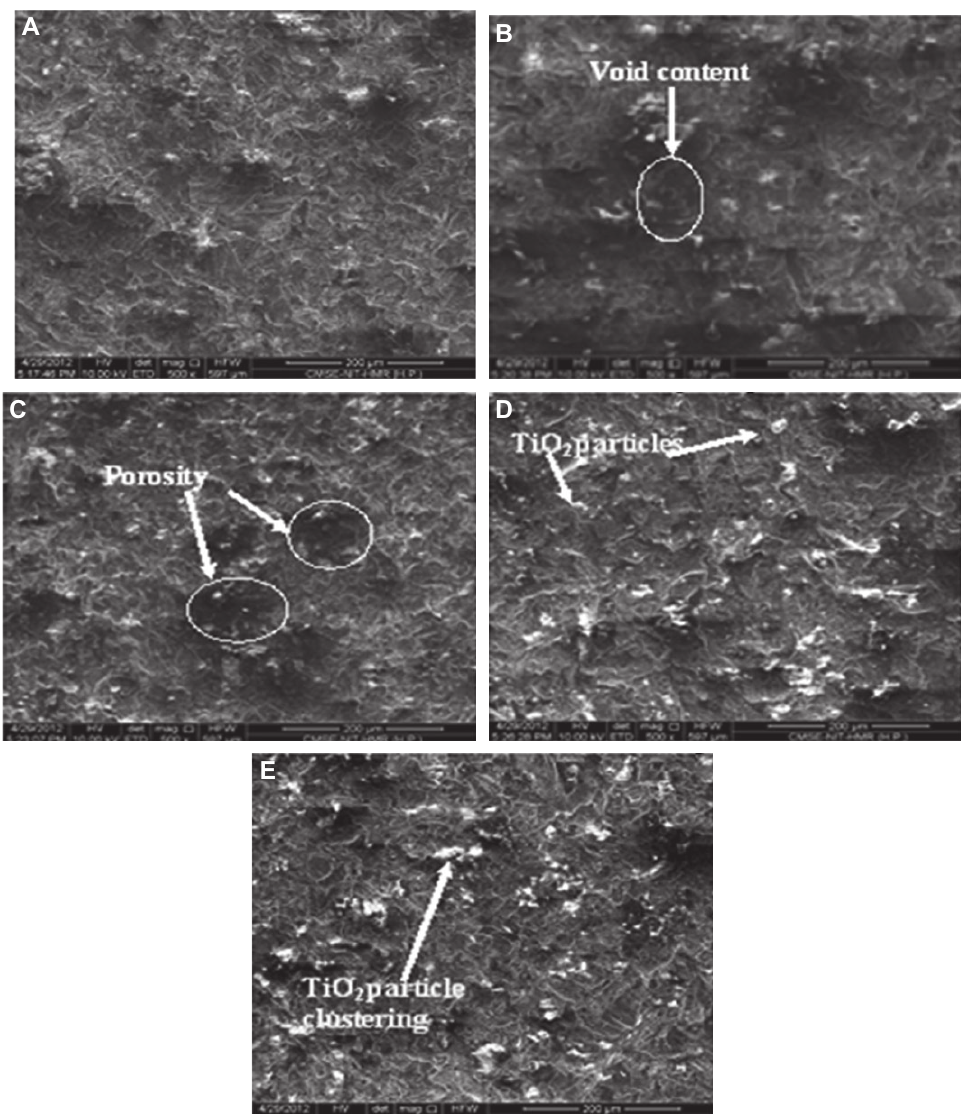
Figure 11 SEM graph for micro-TiO micro-TiO -filled A384 alloy composites. (C) SEM for 4 wt.- % micro-TiO 2 A384 alloy composites. (E) SEM for 8 wt.- % micro-TiO